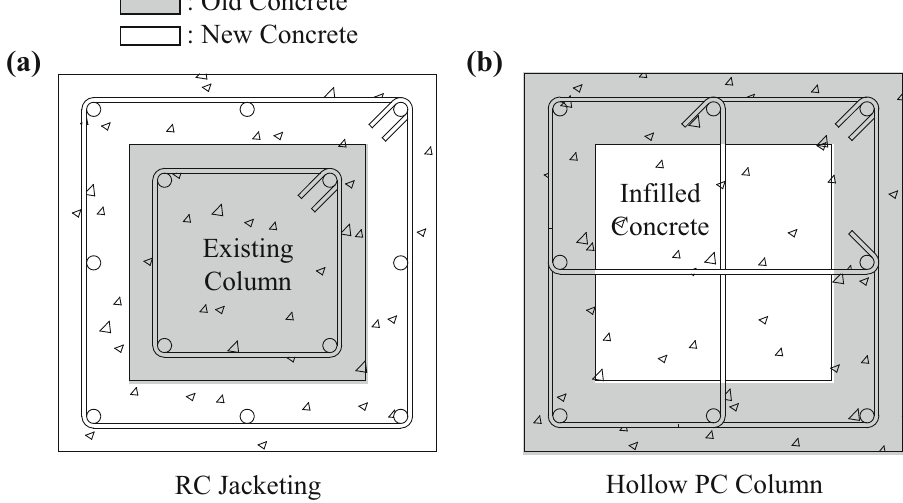
Fig. 1 Example of hybrid concrete columns: a strengthening of existing column and b concrete-filled hollow PC